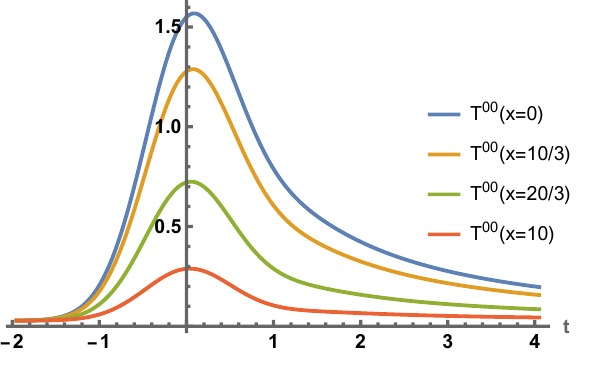
Figure 6 . On the left: the x and z components of the pressure, T zz and T xx , at O ( (cid:15) ) , shown as a function of time at x = y = z = 0 . Again we see good agreement with the results in [3] (red dots), slowly deteriorating for T xx at late times. On the right: the x -component of the pressure T xx up to order O ( (cid:15) ) (solid blue line), shown as a function of time at x = y = z = 0 compared with the inclusion of partial O ( (cid:15) 2 ) -corrections. Again the red dots represent the exact result from [3]. The black dashed line includes partial O ( (cid:15) 2 ) -corrections discussed in section 4.5.